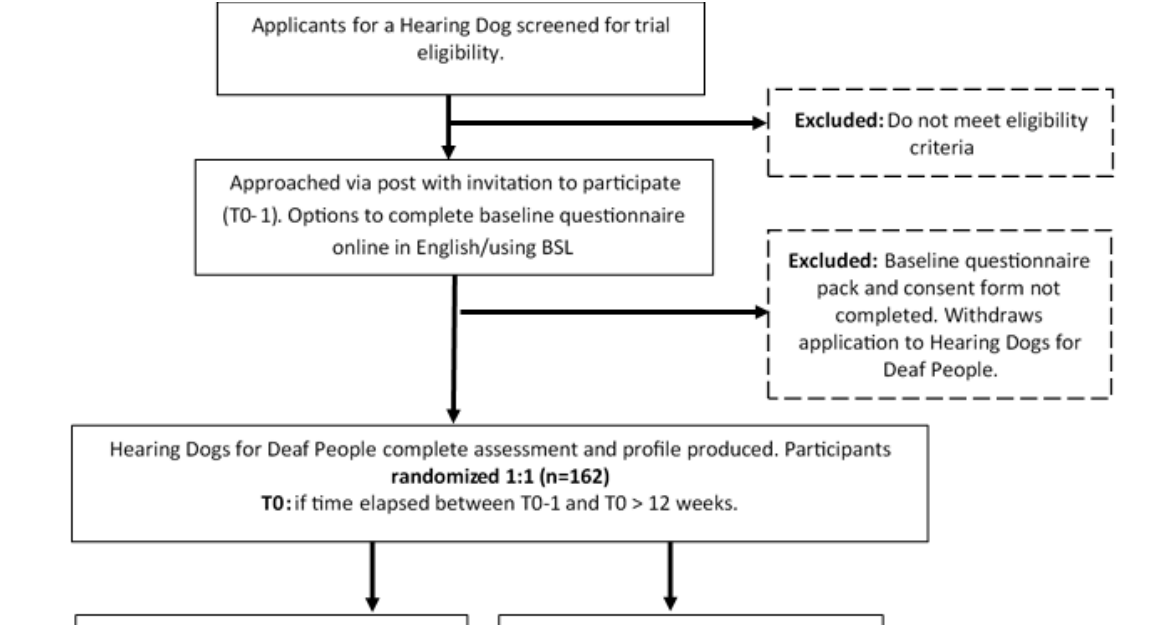
Figure 1. Flow of trial participants through partnerships between deaf people and hearing